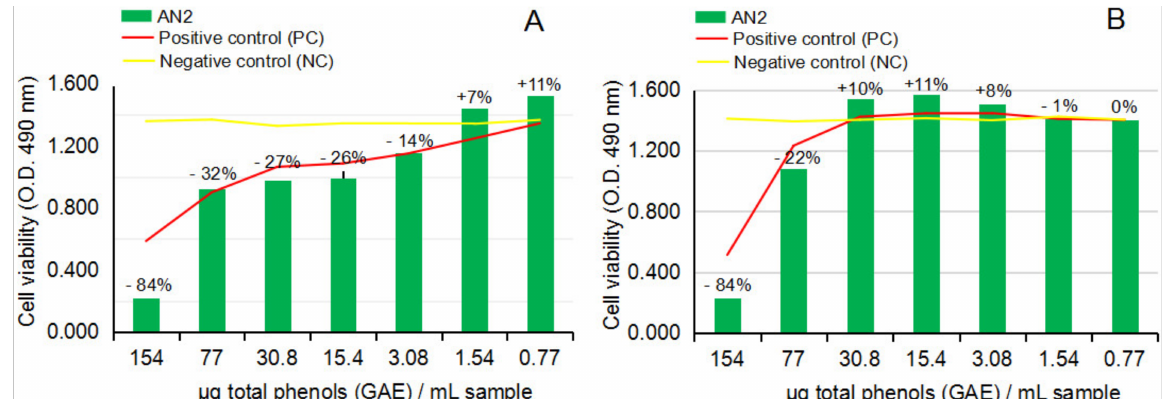
Figure 9. Effect of hot ethanolic extract from dried Anemone nemorosa L. plant material (AN2) on human tumor brain cell line U87, in anti-proliferative MTS assay. ( A ) U87 cell line viability after 24 h of exposure to test vegetal extract AN2. ( B ) U87 cell line viability after 48 h exposure to test vegetal extract AN2. All determinations were made in triplicate series, and the results are calculated as an average. The graphs present the percentage of cell viability in each dilution point series by comparison to negative control point series (CN). By statistical calculation, the results on the U87 after 24 h of exposure to AN2 are statistically significant ( p < 0.05, n = 3), while the results at 48 h were not statistically significant ( p > 0.05, n =